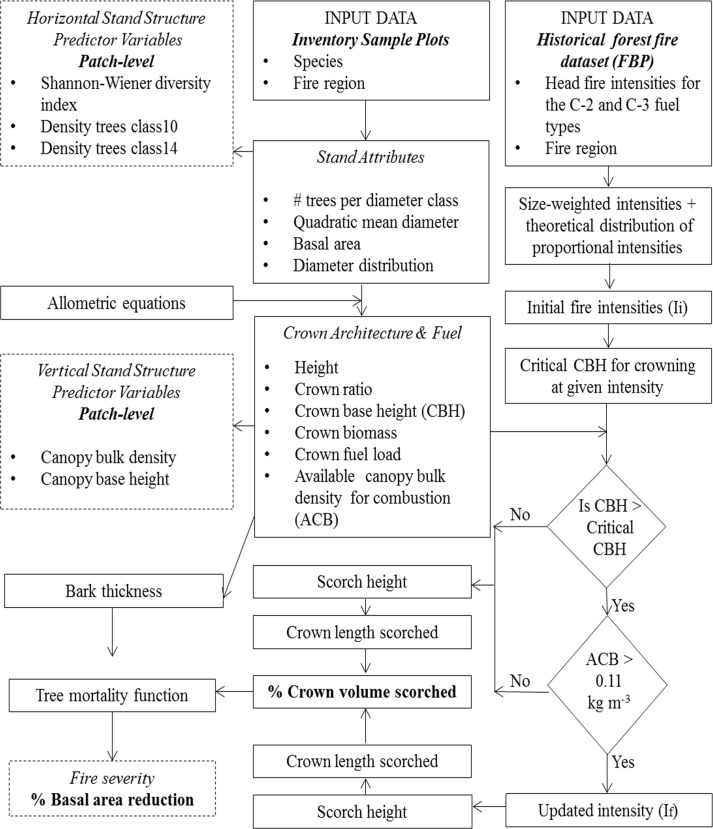
Fire severity model conceptual diagram.Flow diagram of the fire severity model, relating geographically stratified samples of initial fire intensities and forest patch diameter distributions to perform the simulation experiment. Diameter distributions were used to derive fuel and stand structural measures. Crown fire initiation and vertical propagation of a fire was evaluated given the initial fire intensity and the patch canopy fuel characteristics. If crowning occurs, fire intensity is updated and corrected for crown fires [3]. Foliage consumption or scorching is calculated from flame height and foliage profiles. This allows us to calculate size-class specific mortality rates, leading to a patch-level severity measure of basal area loss.